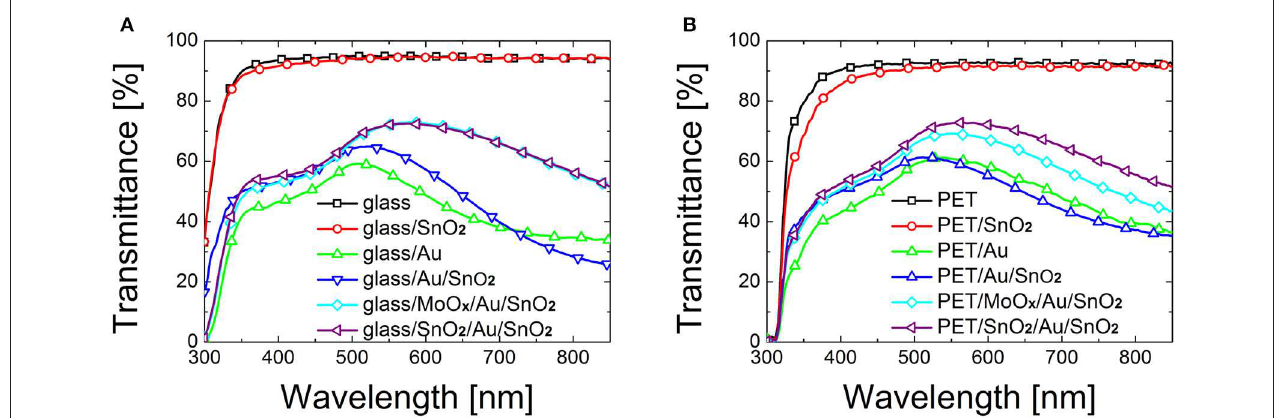
FIGURE 1 | Transmittance of bare substrate, SnO 2 ( ∼ 25nm), Au (10nm), Au (10nm)/SnO 2 ( ∼ 15nm) bilayer, and dielectric/metal/dielectric electrodes based on SnO 2 ( ∼ 25nm)/Au (10nm)/SnO 2 ( ∼ 15nm) and MoO x (18nm)/Au (10nm)/SnO 2 ( ∼ 15nm) deposited on (A) glass and (B) PET.